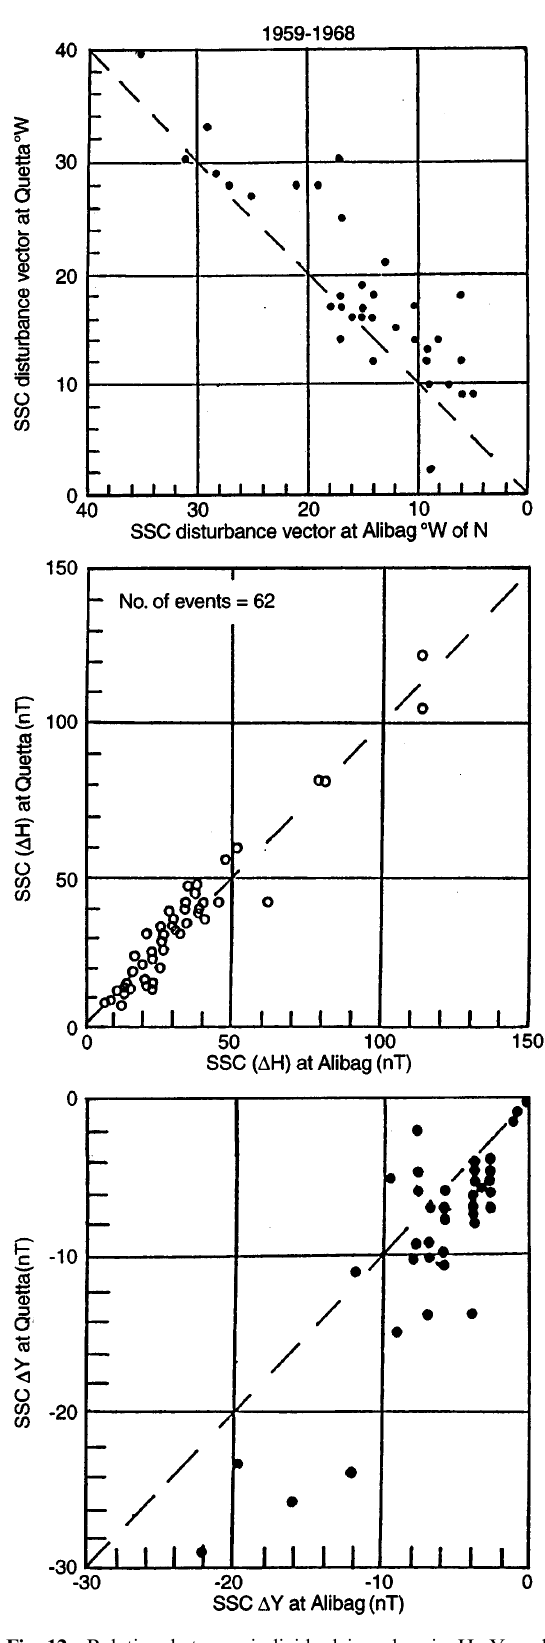
Fig. 12. Relation between individual impulses in H, Y and distur- bance vector at Alibag